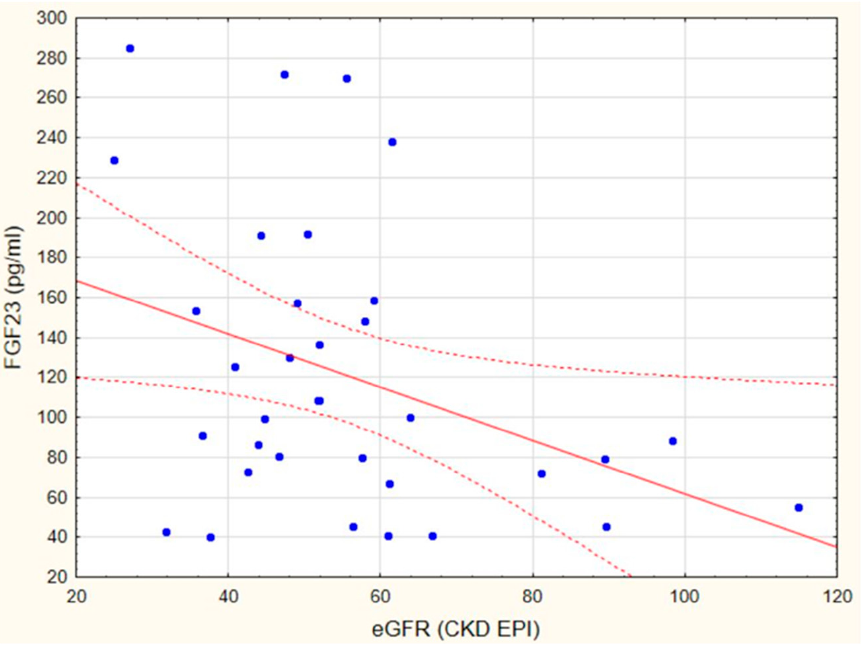
Figure 4. The correlation between FGF-23 and eGFR (CKD EPI) in KTRs group (R Sperman = 0.5; p < 0.05). Table 4. The prevalence of elevated ADMA and hs-CRP depending on DM